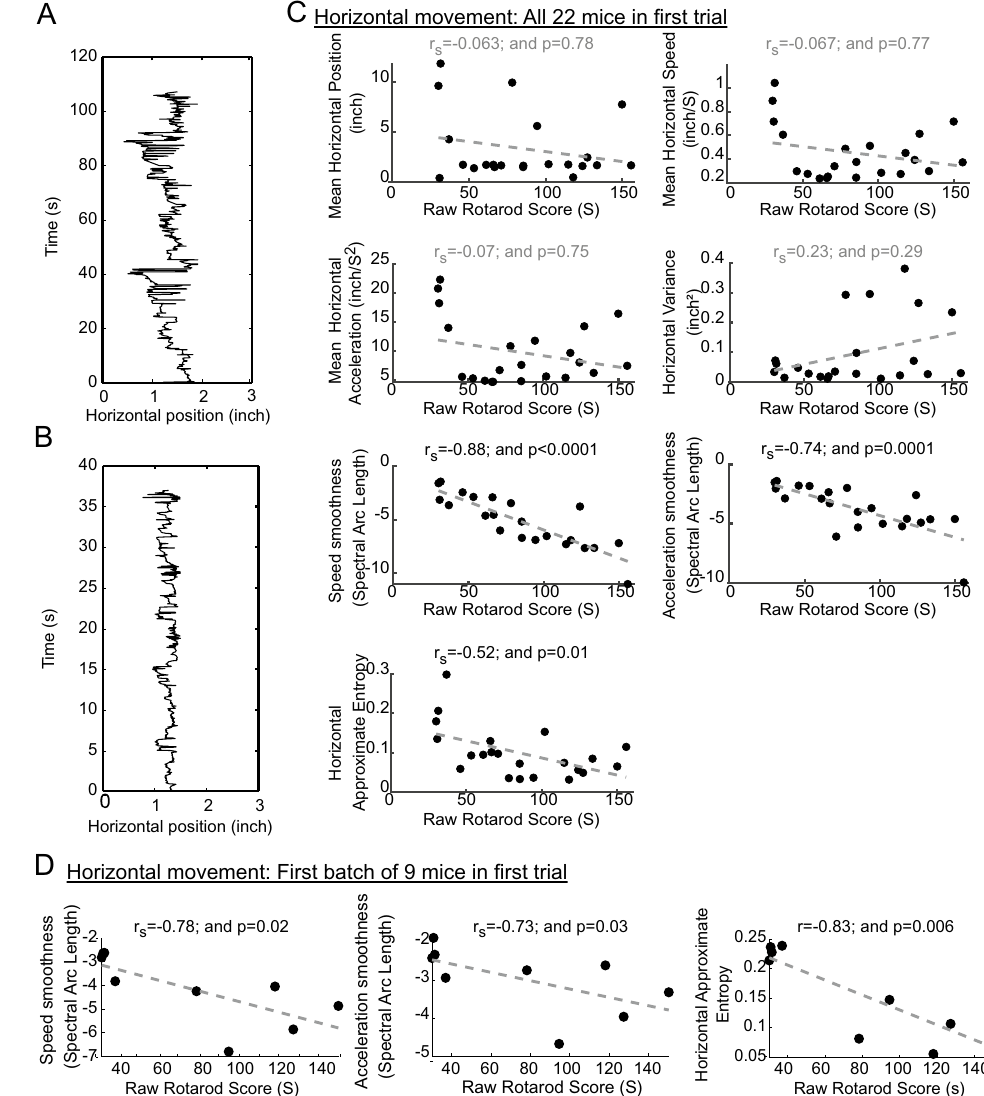
Figure 3. Relationship between first trial horizontal paw position intra-session features and rotarod scores across mice. ( A , B ) Representative horizontal paw position changes over time for mice with greater ( A ) and smaller ( B ) rotarod scores. ( C , D ) Scatter plots for intra-session features with their best fit line. Spearman correlation coefficient rho (r s ) and a measure of statistical significance (“p”) is provided above each